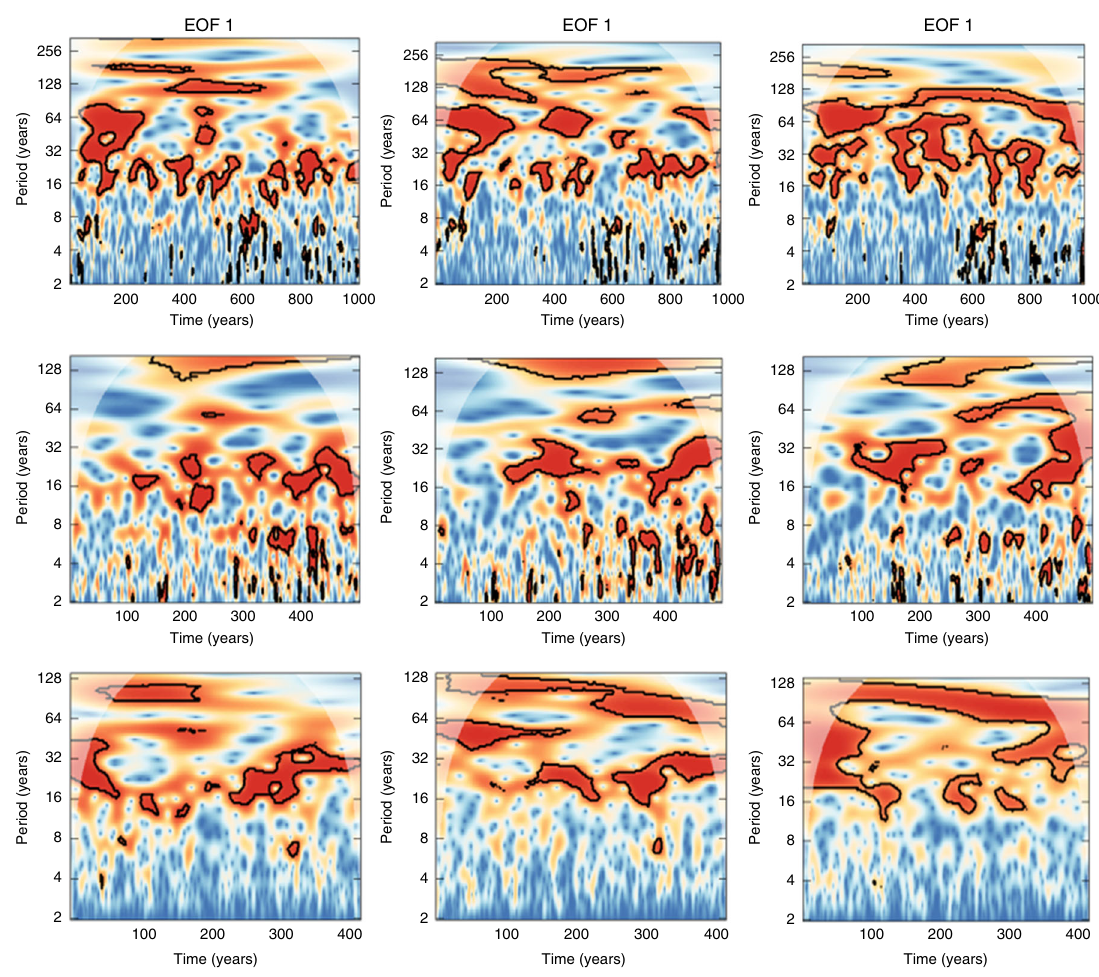
Fig. 9 Cross-wavelet analysis between major hydroclimatic drivers and hydroclimatic patterns. Temperature (upper panel), winter NAO (mid panel) and AMO (lower panel) vs. the fi rst three EOF modes of scPDSI. The black contour designates statistical signi fi cance ( p > 0.95, assuming autoregressive noise spectra) and the cone of in fl uence, where edge effects can potentially distort the picture, is shown as a lighter